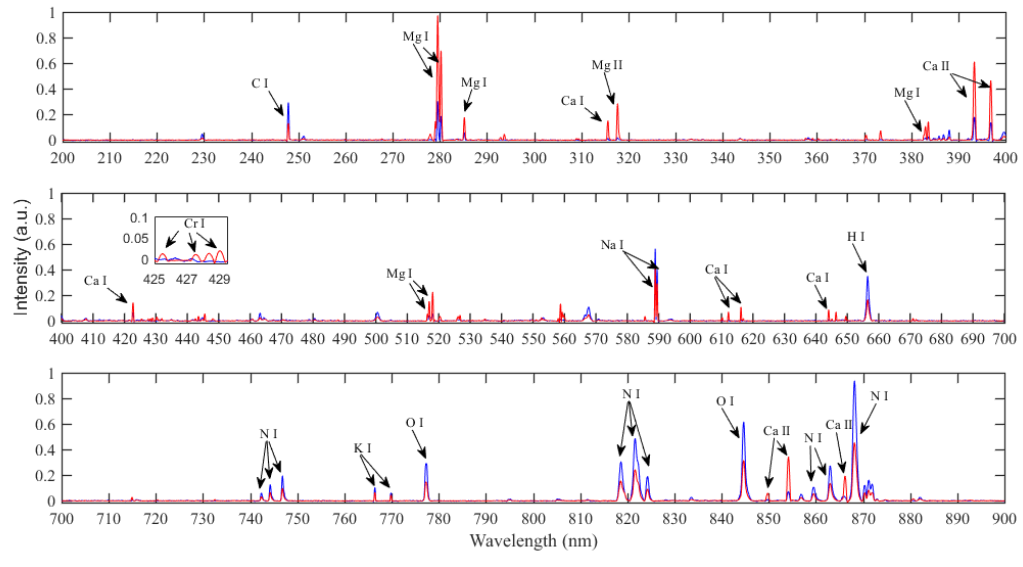
Figure 3. LIBS spectra of pure edible gelatin and industrial gelatin with prominent identified elements. Table 1. Spectral emission lines of the main elements in gelatin samples.